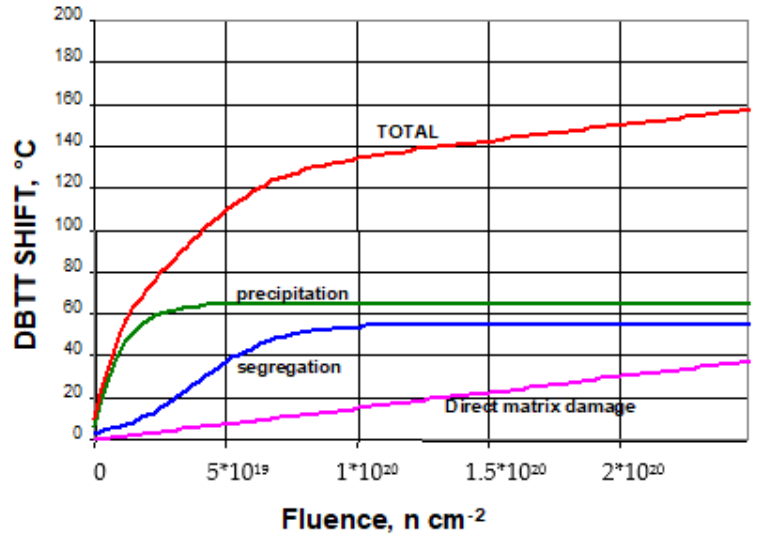
Figure 1. The processes of the radiation embrittlement. Direct matrix damage depends on the displaced atoms, and until large fluences, it is rational with the fast neutron fluence [4]. The precipitations and segregations occur at the beginning of the irradiations and saturating at medium fluence values because the low displacement tough elements move into the segregations and precipitations and become depleted in the matrix.